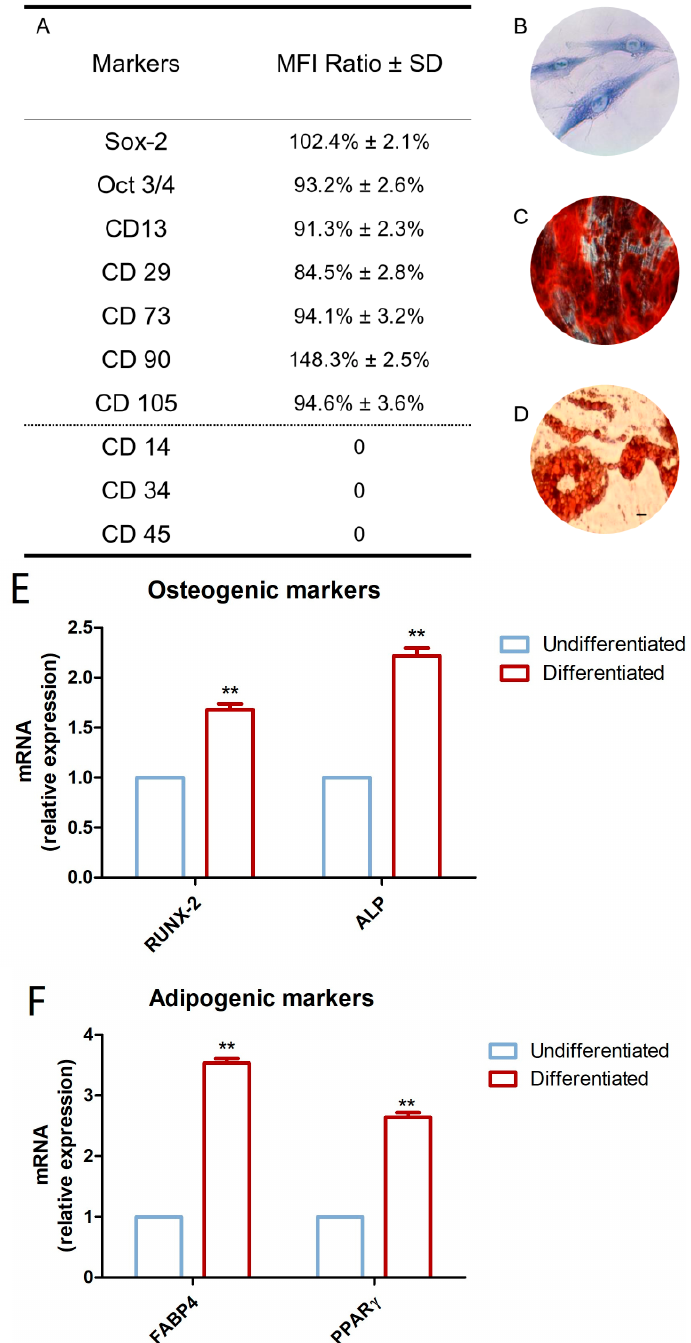
Figure 2. Huma Dental Pulp Stem Cells (hDPSC) characterization. ( A ) Cytofluorimetric detection of hDPSCs at second passage. Median Fluorescence Intensity (MFI) ratio is the average of five di ff erent biological samples ± standard deviation (SD); cuto ff ratio positivity > 2.0. ( B ) Plastic-adherent hDPSCs observed by inverted light microscopy, stained with toluidine blue solution. ( C ) Osteogenic di ff erentiated hDPSCs stained with Alizarin Red S solution. ( D ) Adipogenic di ff erentiated hDPSCs stained with Adipo Oil red O solution. ( E ) Real Time-Polimerase Chain Reaction (RT-PCR) of Runt-related transcription factor 2 (RUNX2) and Alkaline Phosphatase (ALP) performed in undi ff erentiated and di ff erentiated hDPSCs. ( F ) RT-PCR of Fatty Acid-Binding Protein 4 (FABP4) and Peroxisome Proliferator-Activated Receptor Gamma (PPAR ) performed in undi ff erentiated and di ff erentiated hDPSCs. Scale bar: 10 µ m. ** p <